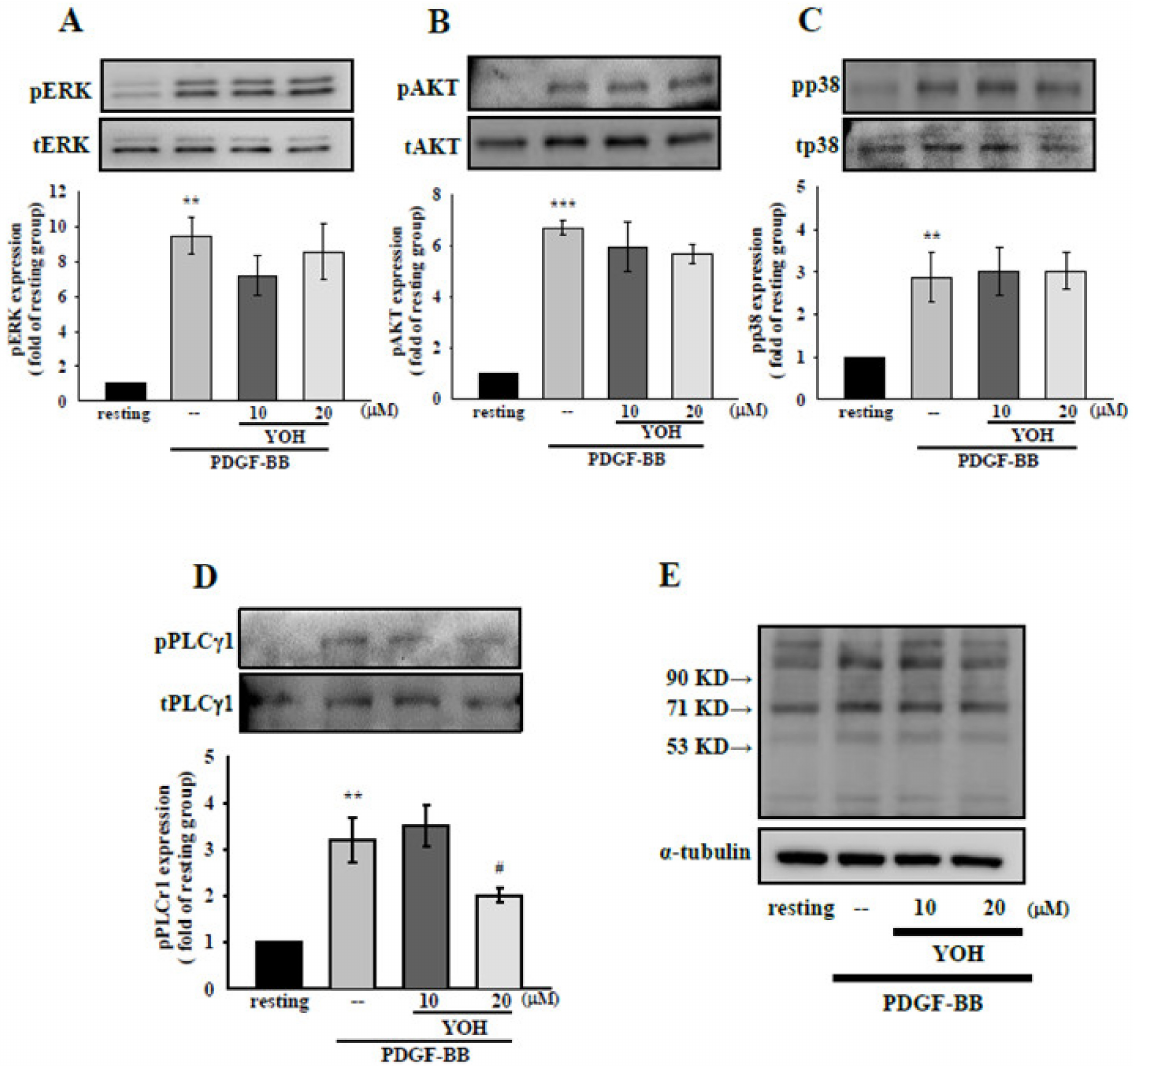
Figure 4. Effects of YOH on ERK1/2, p38, AKT, and PLC γ 1 pathway activation in PDGF-BB- stimulated MOVAS-1 cells. MOVAS-1 cells were incubated with YOH (10 or 20 µ M) for 45 min and then treated with PDGF-BB (10 ng/mL) for 10 min. The protein expression levels of ( A ) phospho- ERK1/2, ( B ) phospho-p38, ( C ) phospho-AKT, ( D ) phospho-PLC γ 1, and ( E ) phospho-(Ser) PKC substrates were determined through Western blotting. ** p < 0.01, *** p < 0.001 compared with the resting group; # p < 0.05 compared with the positive group. Data are presented as the mean ± S.E.M. ( n =